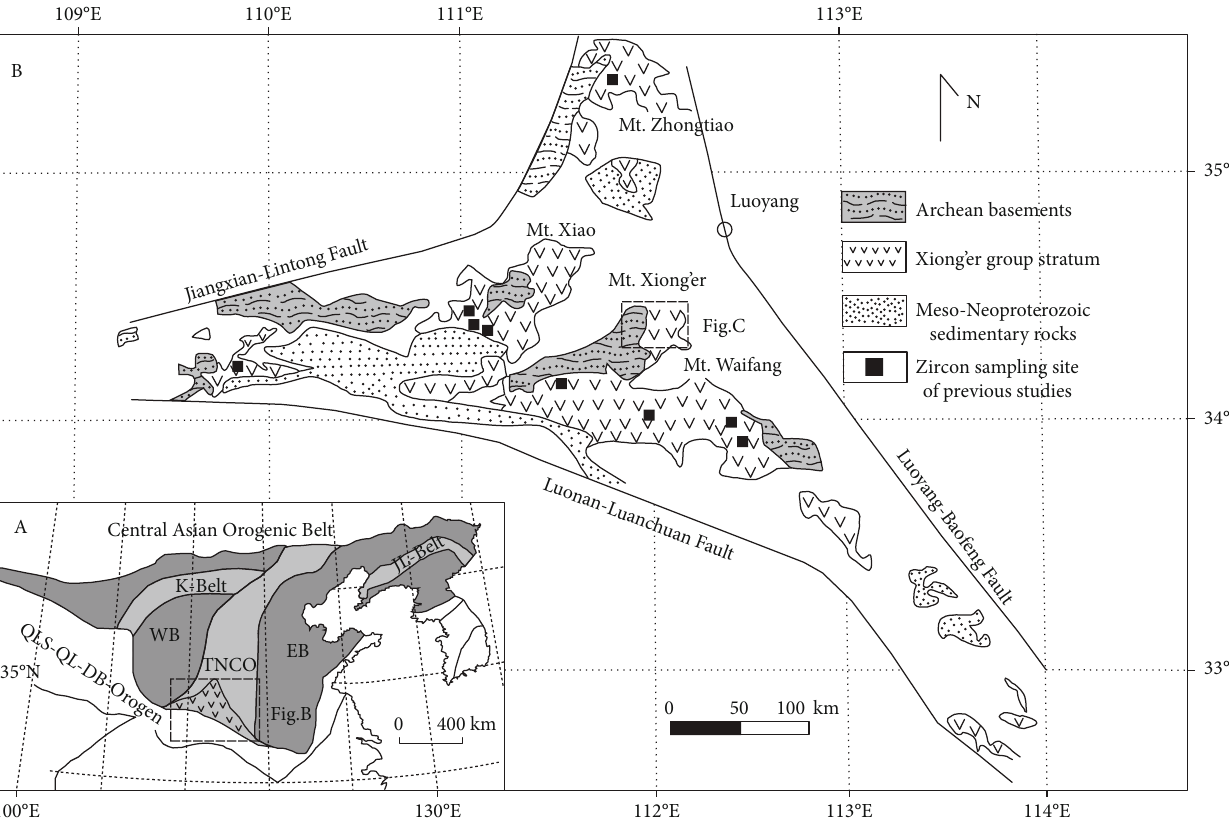
Figure 1: Distribution map of volcanic rocks in the Xiong ’ er Group. (after He et al. [1]). WB: Western Block; EB: Eastern Block; TNCO: Trans-North China Orogen; K-Belt: the Khondalite Belt; JL-Belt: the Jiao-Liao Belt; QLS-QL-DB Orogen: Qilianshan-Qinling-Dabie